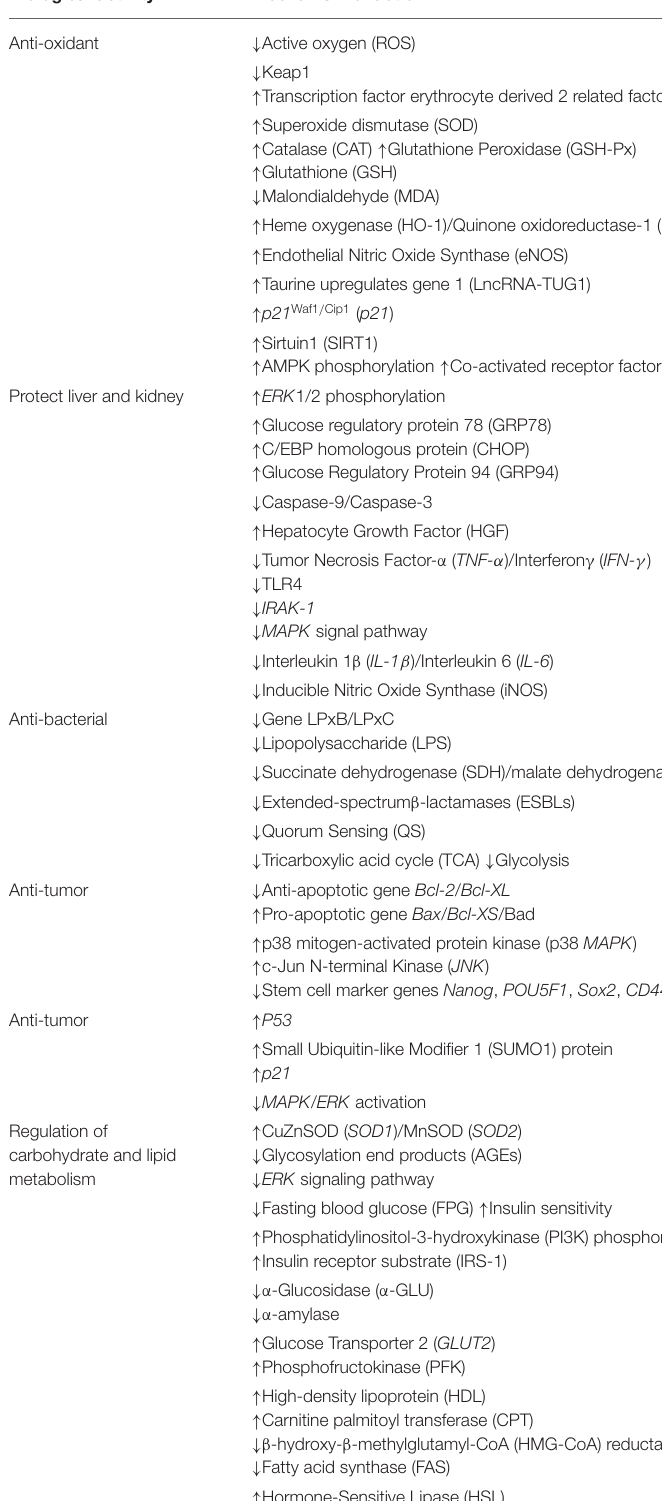
TABLE 1 | The biological activity mechanisms of CGA ( ↑ increase/enhance, ↓ decrease/inhibit). Biological activity Mechanism of